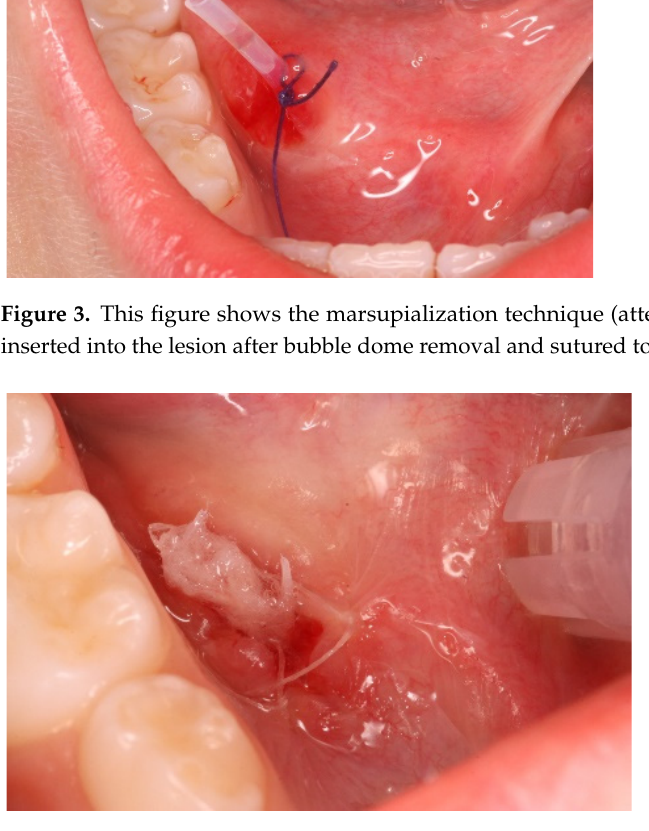
Figure 4. This figure shows the marsupialization technique (attempt n° 2): gauze is inserted into the lesion after bubble dome removal and sutured.